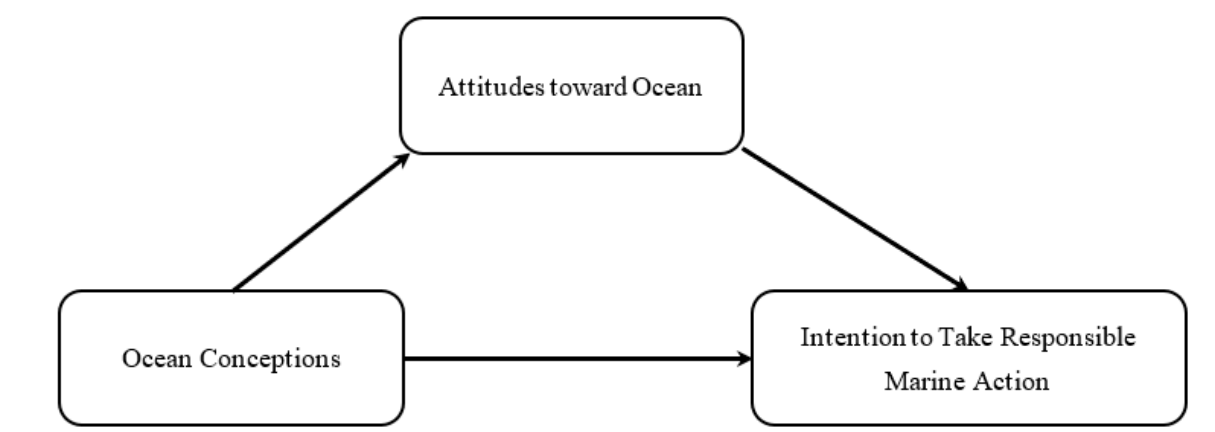
Figure 2. The hypothesized mediation model.